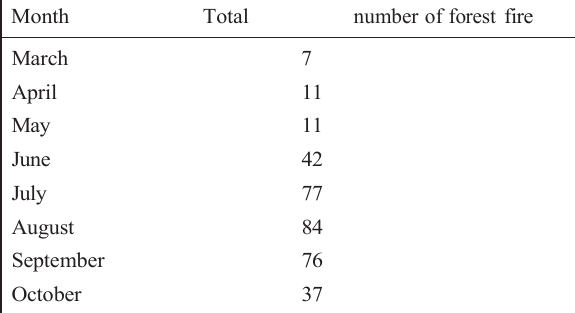
Table 2. Total number of forest fires that occurred during the period 2008–2021.